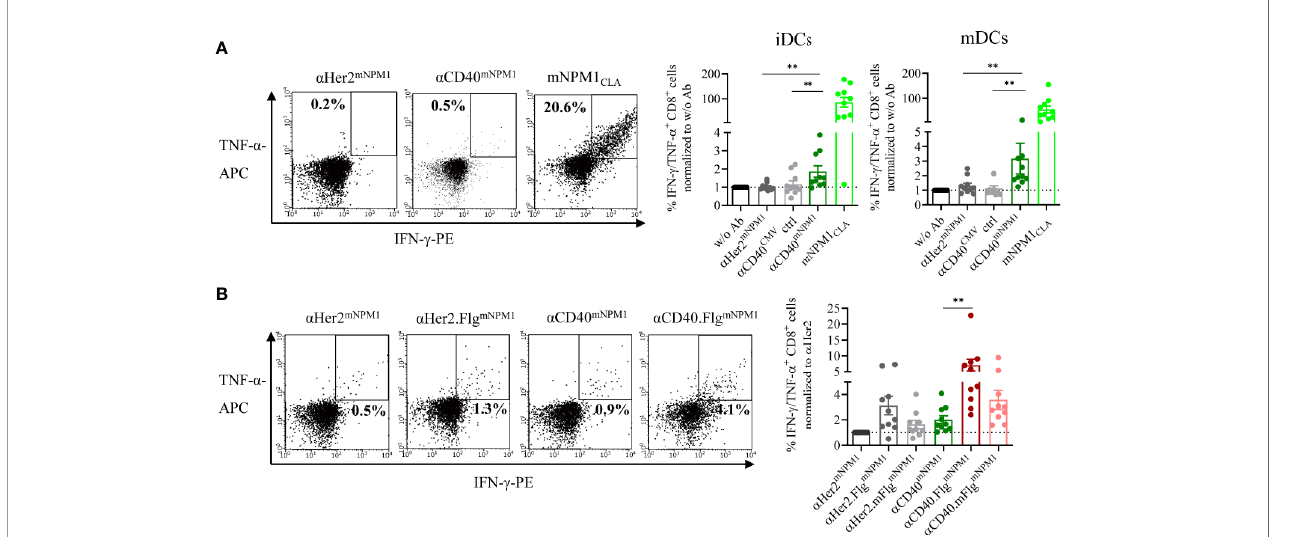
FIGURE 6 | mNPM1-speci fi c peptides fused to a CD40 were ef fi ciently cross-presented on the DC surface and induced activation of mNPM1-responsive T cells that was signi fi cantly enhanced by TLR5 ligation. (A) Allogeneic DC – T cell co-culture of mNPM1 CLA -speci fi c T cells and HLA-A*02:01 + iDCs. DCs were pre-incubated with a Her2 mNPM1 , a CD40 mNPM1 , a CD40 conjugated to a control peptide ( a CD40 CMV ) or with the processed mNPM1 CLA peptide. As a readout for T cell activation, IFN- g - and TNF- a - producing CD8 + T cells were counted by fl ow cytometry ( n = 10 donors). (B) Allogeneic DC – T cell co-culture of mNPM1 CLA -speci fi c T cells and HLA-A*02:01 + iDCs. DCs were pre-incubated with a CD40 mNPM1 , a CD40.Flg mNPM1 , a CD40.mFlg mNPM1 or the respective a Her2 controls. T cell activation was measured by fl ow cytometry ( n = 10 donors) and normalized to w/o Ab or to the a Her2 control for each donor, respectively. Bars represent mean ± SEM. For statistical analysis, a Wilcoxon-signed rank test was applied. ** p <